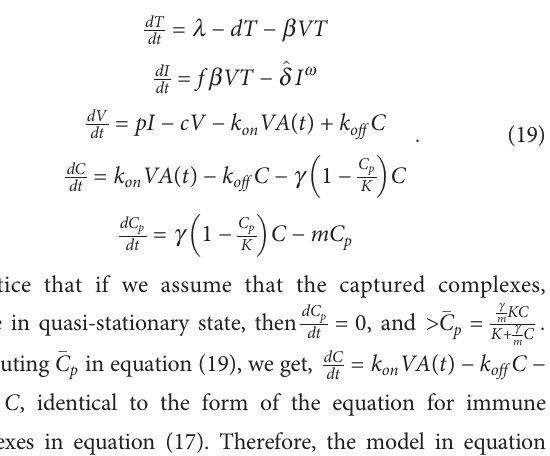
(green dashed lines in Figure 7 ), explaining the initial fast decay. As the phagocytic capture is smaller for less sensitive immune are cleared producing a fast rebound over the next hours.